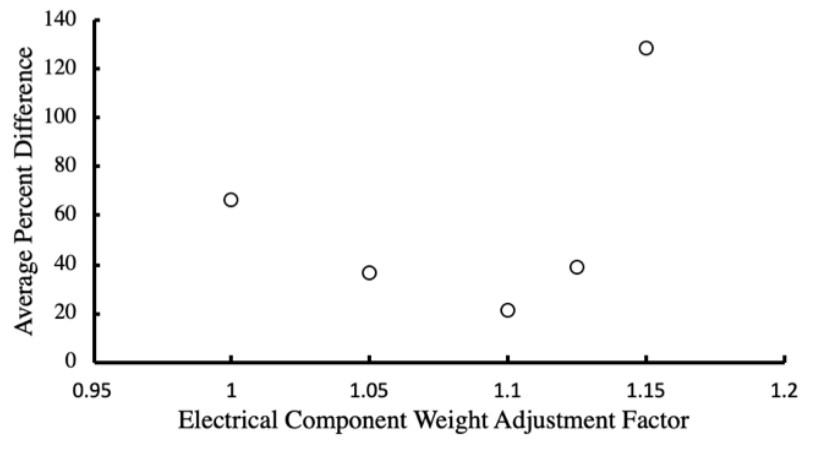
Figure 4. The summed average percent difference in the design parameters between the design and test vehicle as a function of the weight adjustment factor.